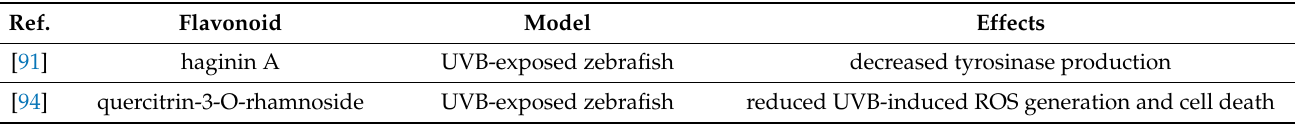
Table 3. Studies assessing flavonoid effects against UVB-induced toxicity in zebrafish models.